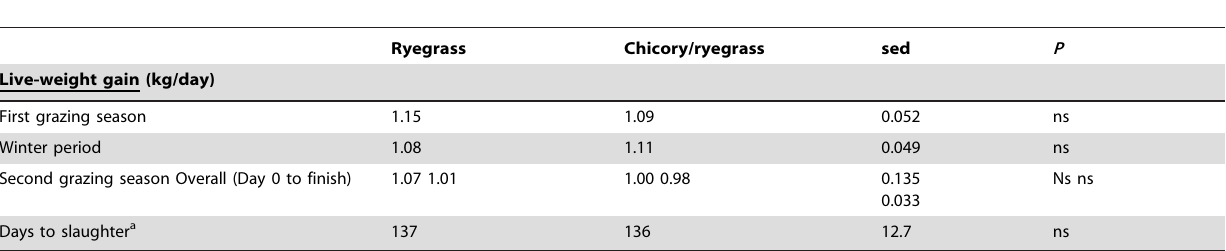
Table 3. Performance of beef steers ( n =36) grazing either chicory/ryegrass or ryegrass only swards during their first and second grazing season and during the winter period between whilst